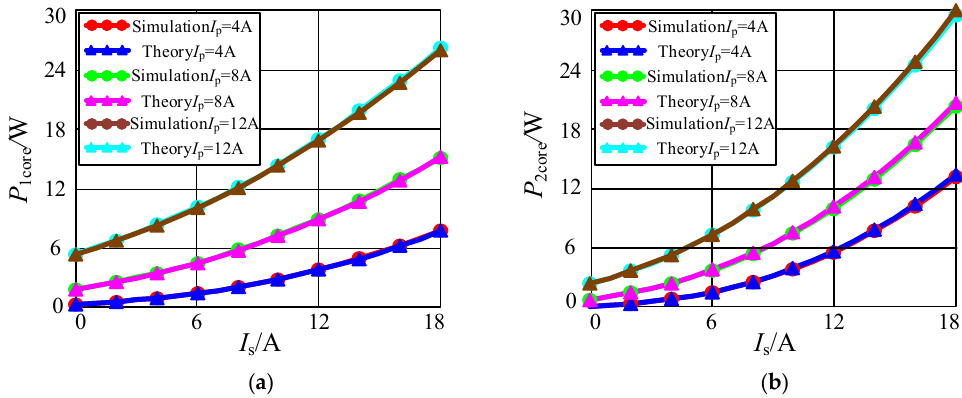
Figure 10. The core losses of the disk core obtained by theoretical calculation and simulation under different winding currents. ( a ) Transmitter core; ( b ) Receiver core. In the same way, the core losses of the transmitter core and the receiver core obtained by theoretical model calculation and FEA simulation are compared under different phase- shifts, as shown in Figure 11, where the transmitter winding current I p = 12